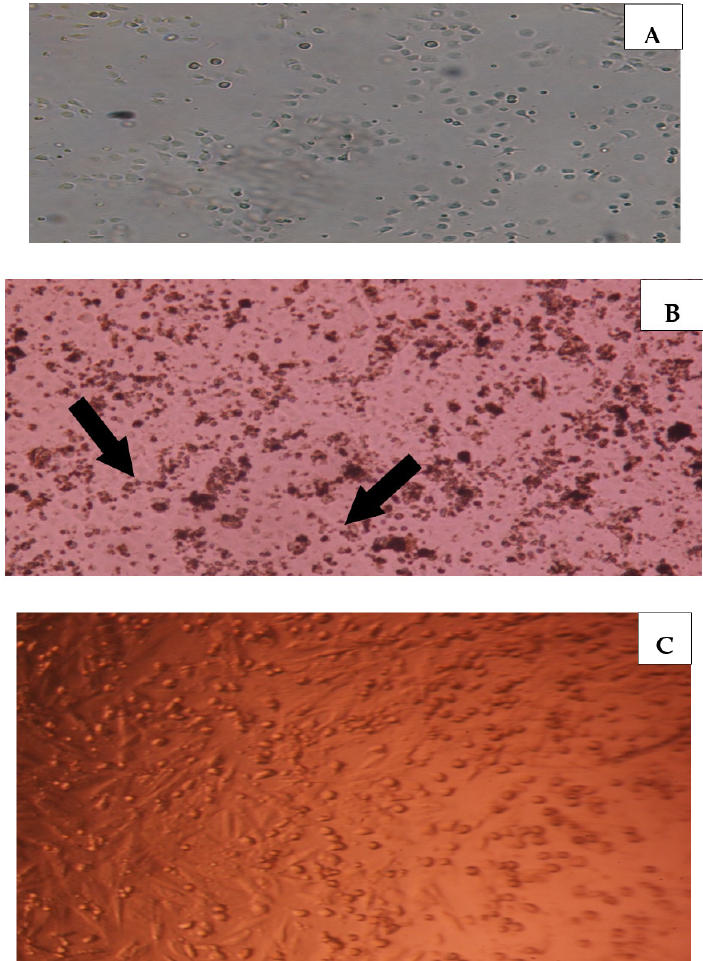
Figure 6. Photomicrographs demonstrating morphological changes of IEC ‐ 6 cells for different treat ‐ ments ( A ) normal; ( B ) model (H 2 O 2 40 μ M,4 h arrows indicating changes in cell shape); ( C ) pre ‐ treated with PSGS 20 μ g/mL for 4 h then exposed to 40 μ M of H 2 O 2 for 4 h.